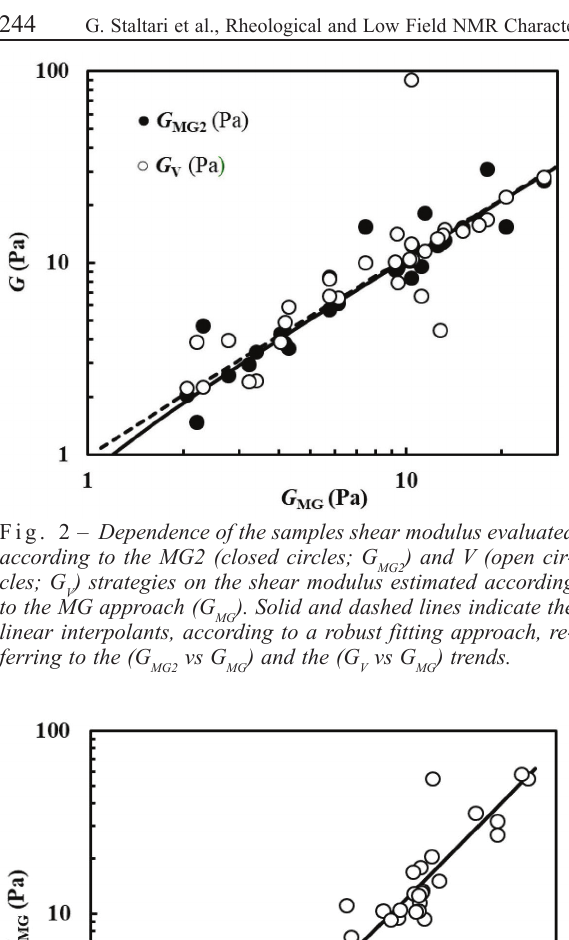
) and the average MG ) pertaining to each sample. av